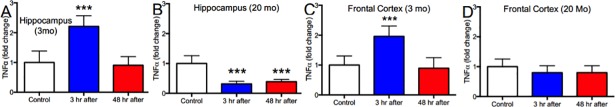
Isoflurane produces age- and region-dependent changes in TNFα gene expression.Mice were anesthetized as described and TNFα measured in the hippocampus and frontal cortex by RT-PCR. TNFα increased transiently in the hippocampus and frontal cortex of young isoflurane anesthetized mice but, like IL-1β, was persistently reduced in the hippocampus but not frontal cortex of old mice demonstrating age and regions specific effects of treatment with isoflurane on TNFα expression. Data expressed as mean ± SD for N = 6 animals per treatment condition. *** p<0.001 relative to age-matched controls by 1-way ANOVA with Dunnett’s test.